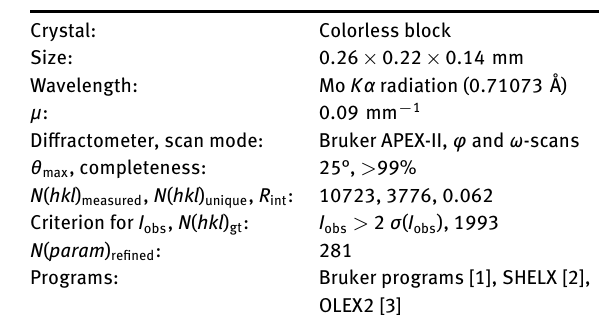
Table 1: Data collection and handling.